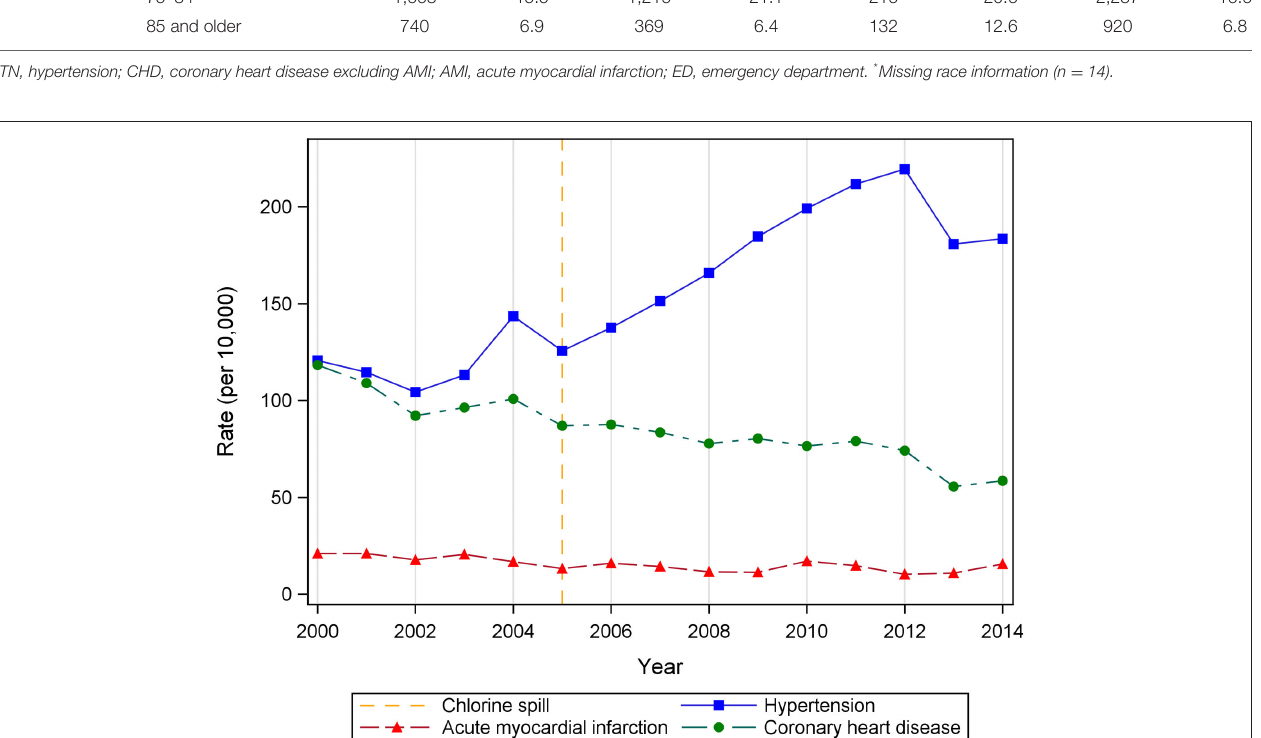
rates of hypertension associated discharges increased from